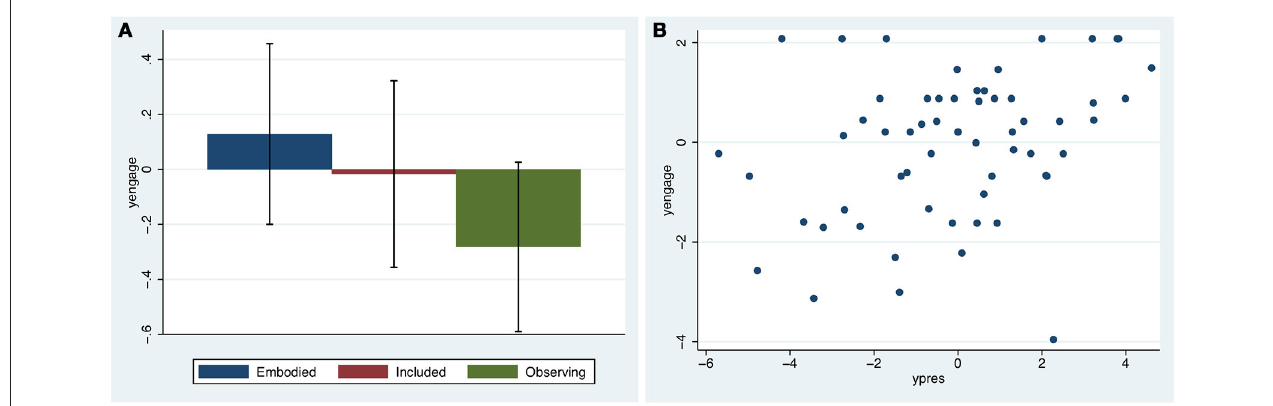
FIGURE 7 | Engagement ( yengage ) (A) Bar chart of means and standard errors of yengage by condition (B) Scatter diagram of yengage by ypres .